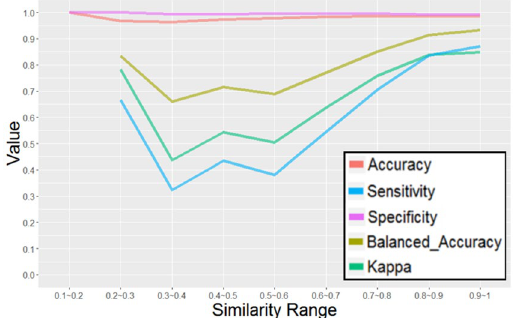
Figure 6. Performance metrics for the test set in each similarity range. The horizontal axis denotes similarity range, and the vertical axis indicates the values for accuracy (red), Balanced Accuracy (ocher), Kappa (green), Sensitivity (blue), and Specificity